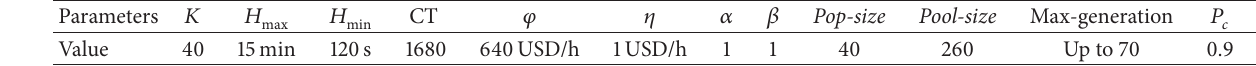
Table 3: Parameters used in numerical example.